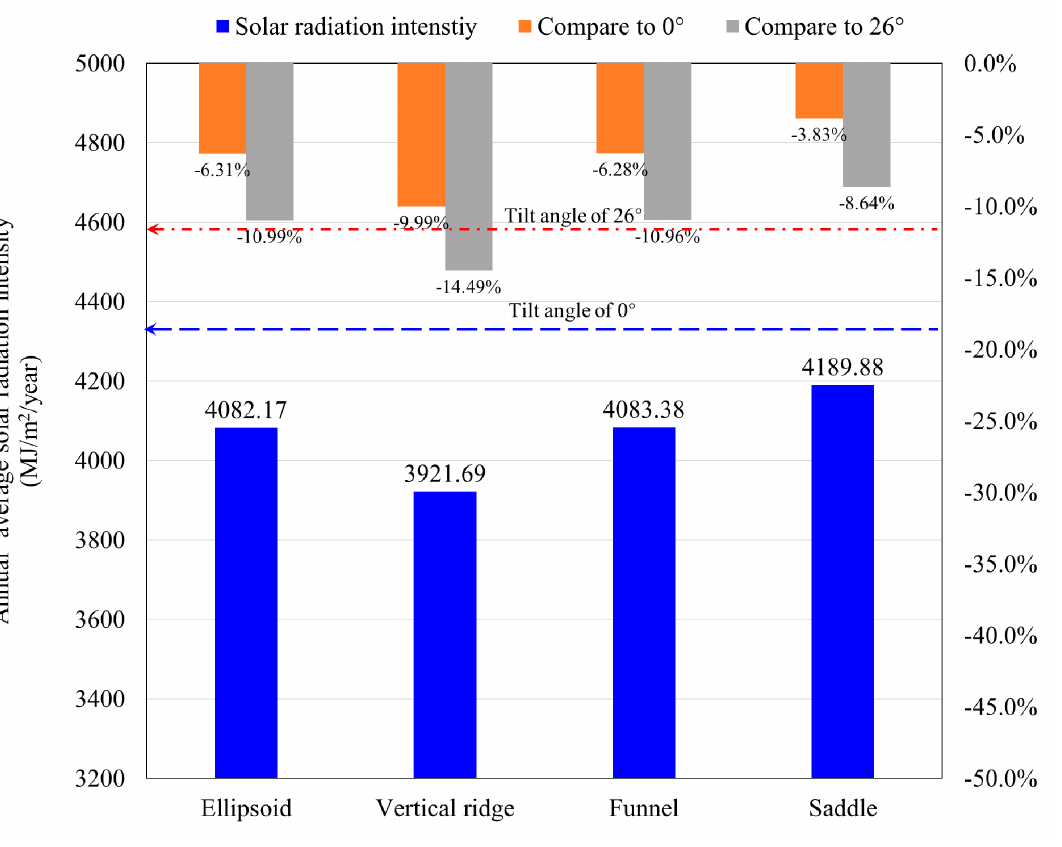
Figure 17. Annual average solar radiation intensity of elliptic gymnasium buildings with the four roof shapes.